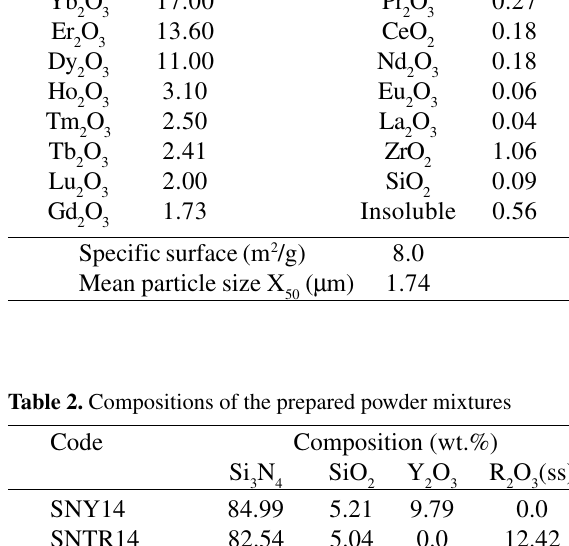
O (ss) analyzed by Atomic Emis- 2 3